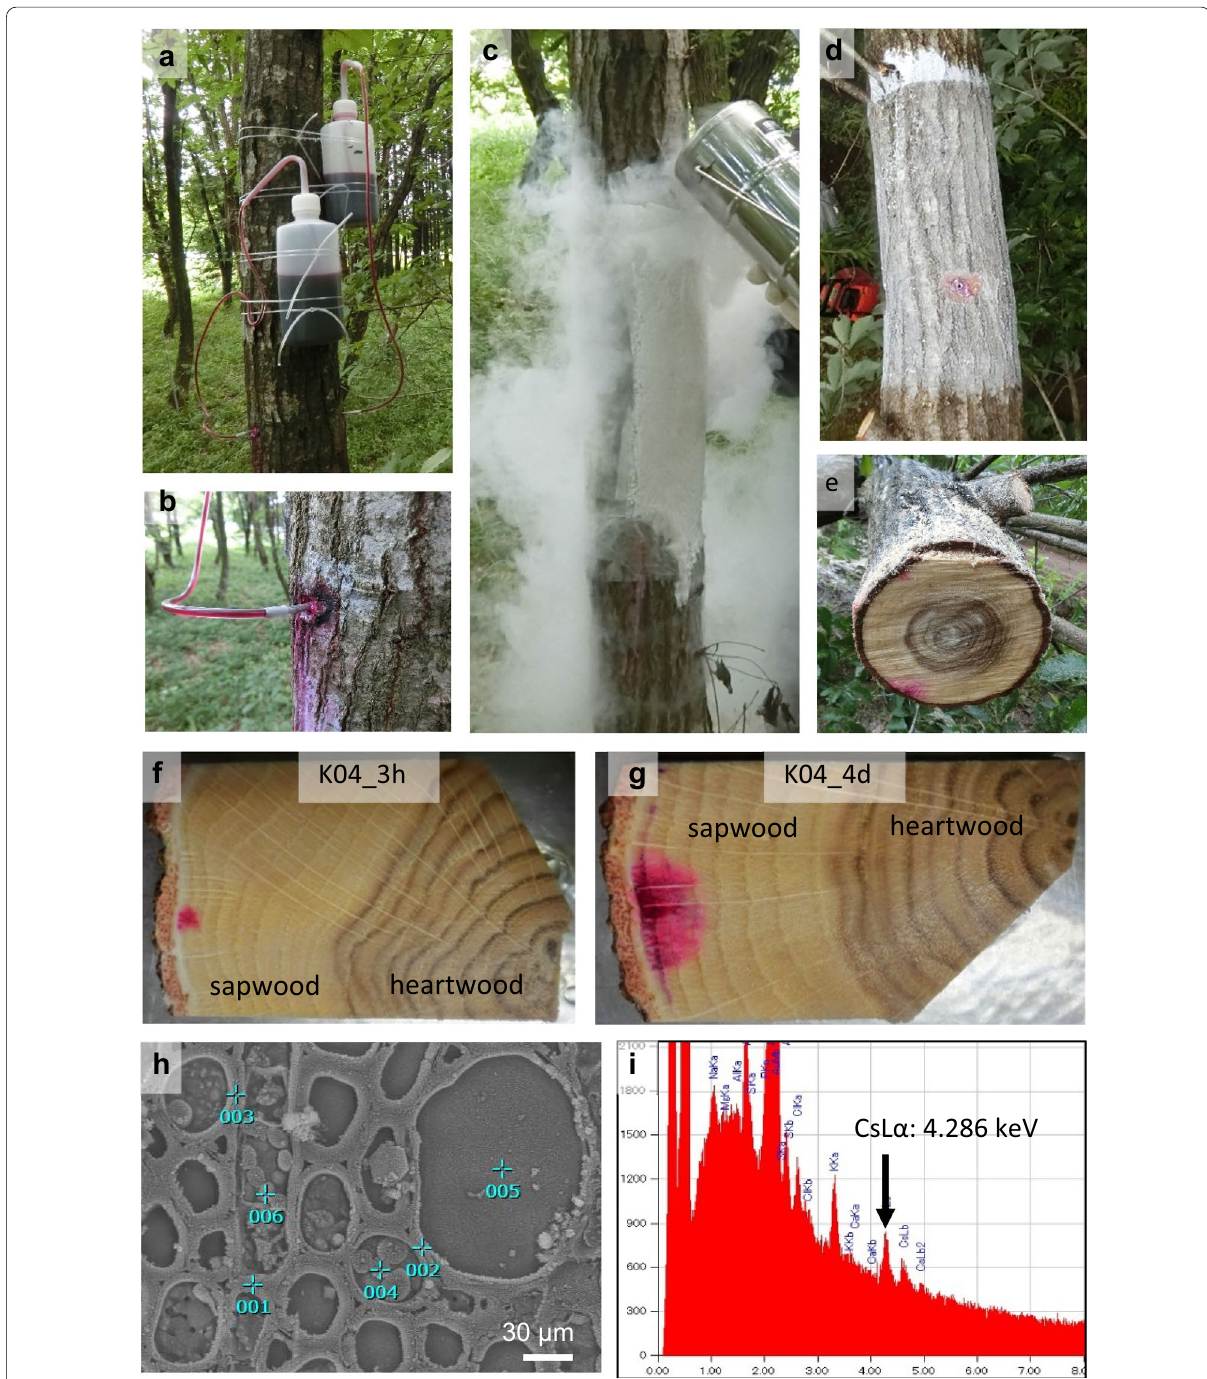
Fig. 1 Schematic representation of sample treatment and cryo-scanning electron microscopy/energy-dispersive X-ray spectroscopy (cryo-SEM/ EDX) point analysis. a , b Bottles with a Cs solution were attached to a trunk approximately 20 cm above the injection hole, and the Cs solution was injected continuously during a defined period (please see Table 1). c , d , e After the injection, a part of the trunk was frozen by liquid nitrogen and the tree was felled. f , g The xylem region where the Cs solution was injected and its conduit were confirmed by the red color achieved by acid fuchsin staining. h , i A fresh transverse surface of the sample block was smoothly cut by cryostat and subjected to observation and analysis by cryo-SEM/EDX. Several points were selected to be analyzed on a secondary electron image, and the characteristic X-ray of each Cs-Lα peak (4.286 keV) was